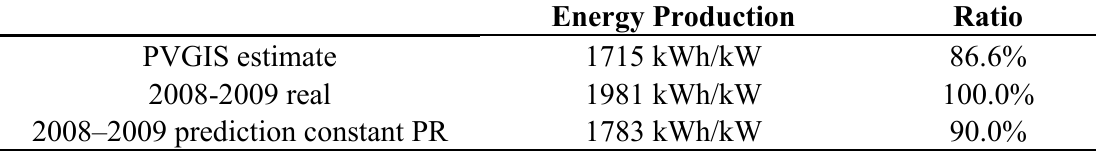
Table 6. PVGIS EP estimate for an average year, real EP in 2009, and predicted EP in 2009 using constant PR at the Sanlúcar la Mayor CPV